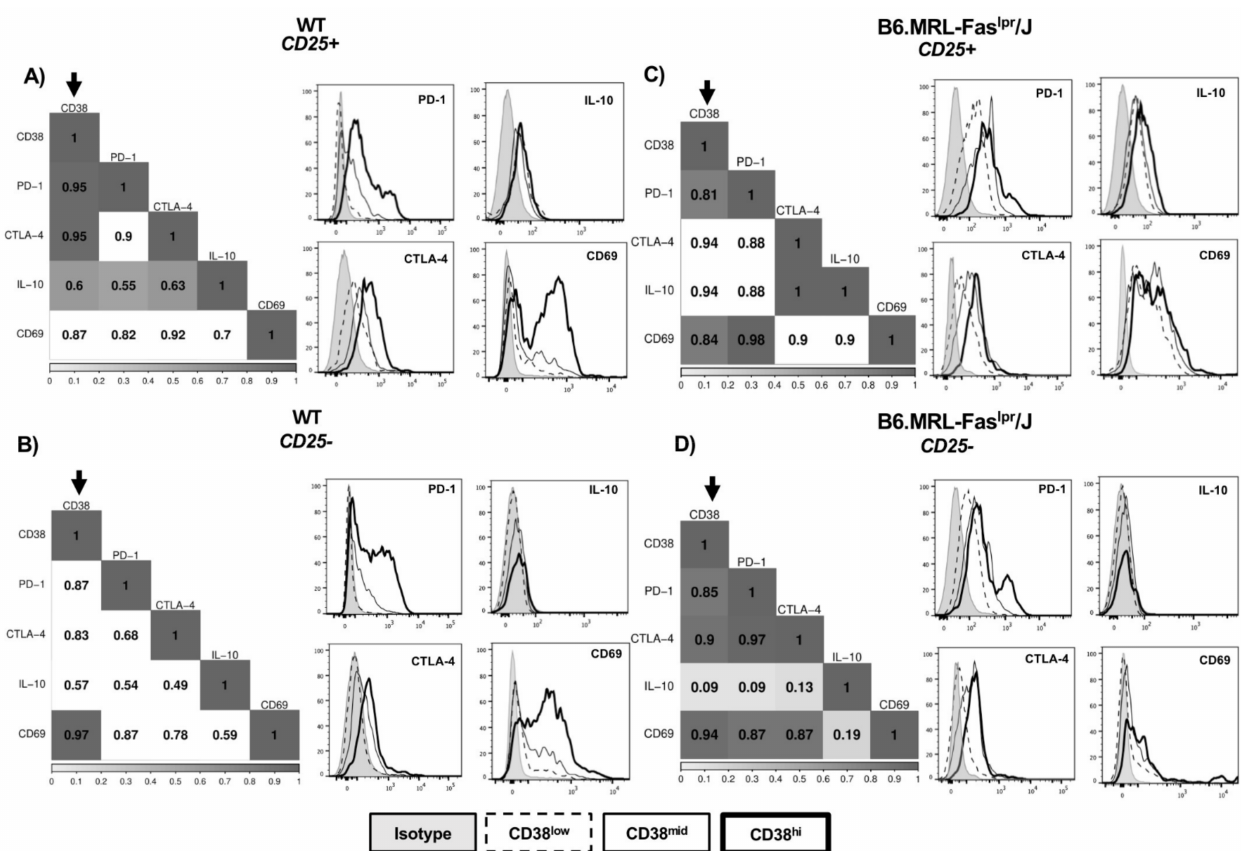
Figure 2. CD38 correlates with immunosuppressive molecules. Correlation matrix and histograms of PD-1, CTLA-4, IL-10, and CD69 expression within CD38 low (dashed line), CD38 mid (black line), and CD38 high (heavy line) subsets in ( A ) WT CD4 + CD25 + T-cells ( n = 6); ( B ) WT CD4 + CD25 − cells ( n = 6); ( C ) B6.MRL-Fas lpr /J CD4 + CD25 + T-cells ( n = 6); and ( D ) Shaded squares indicate correlations with a p < 0.005, while blank squares show non-significative